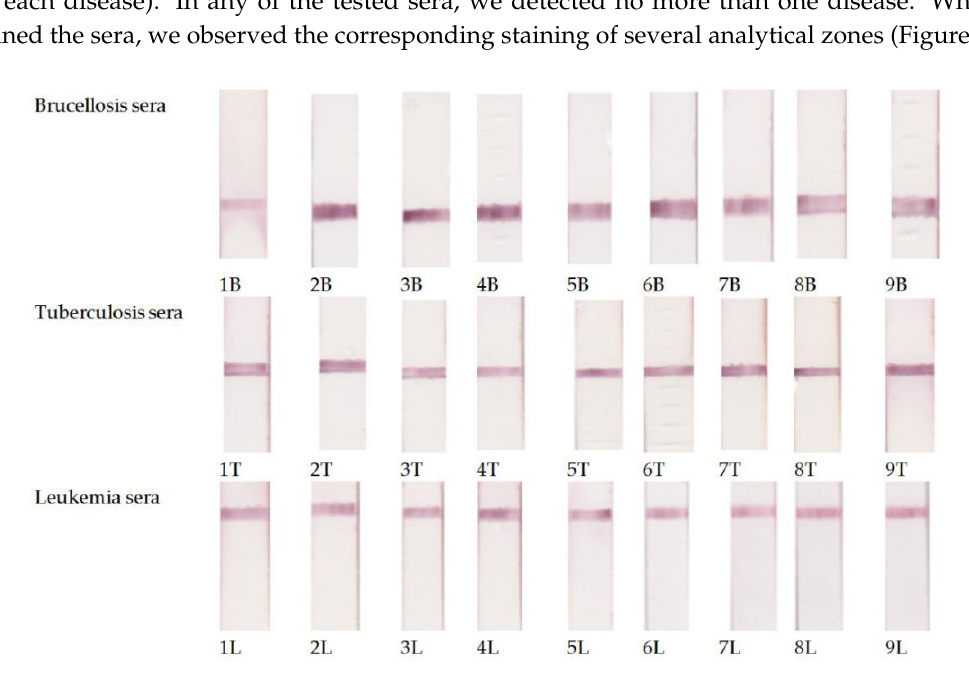
Figure 4. Results of ICA for simultaneous detection of bovine brucellosis (B), tuberculosis (T), and leukemia (L). 1 —positive results for leukemia and tuberculosis; 2 —positive results for leukemia and brucellosis; 3 —positive results for tuberculosis and brucellosis; 4 —positive results for leukemia, tuberculosis, and brucellosis. C—control line with immobilized rabbit anti-bovine immunoglobulins. A panel of 21 animal sera with no signs of brucellosis, tuberculosis, and leukemia was tested. ELISA confirmed the absence of antibodies against the antigens of Br. abortus, M. bovis , and BLV in the sera. None of the sera yielded a positive result. Thus, the specificity of ICA-diagnostics was 100% for all three pathogens. 4. Conclusions A multiplex immunochromatographic test system for the simultaneous serodiagnosis of bovine brucellosis, tuberculosis, and leukemia was developed and tested. The results of the testing demonstrate the possibility of the simultaneous detection of specific antibodies to pathogens of three cattle diseases with a high sensitivity (92–96%) and specificity (100%). The duration of the testing was 10 min.